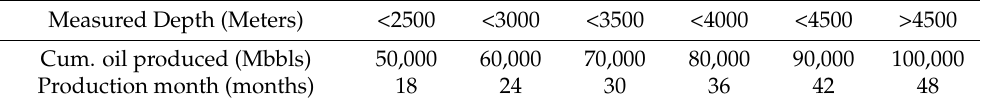
Table 2. Alberta’s incentives for new horizontal oil wells (5% royalty until the maximum is reached). Measured Depth (Meters) <2500